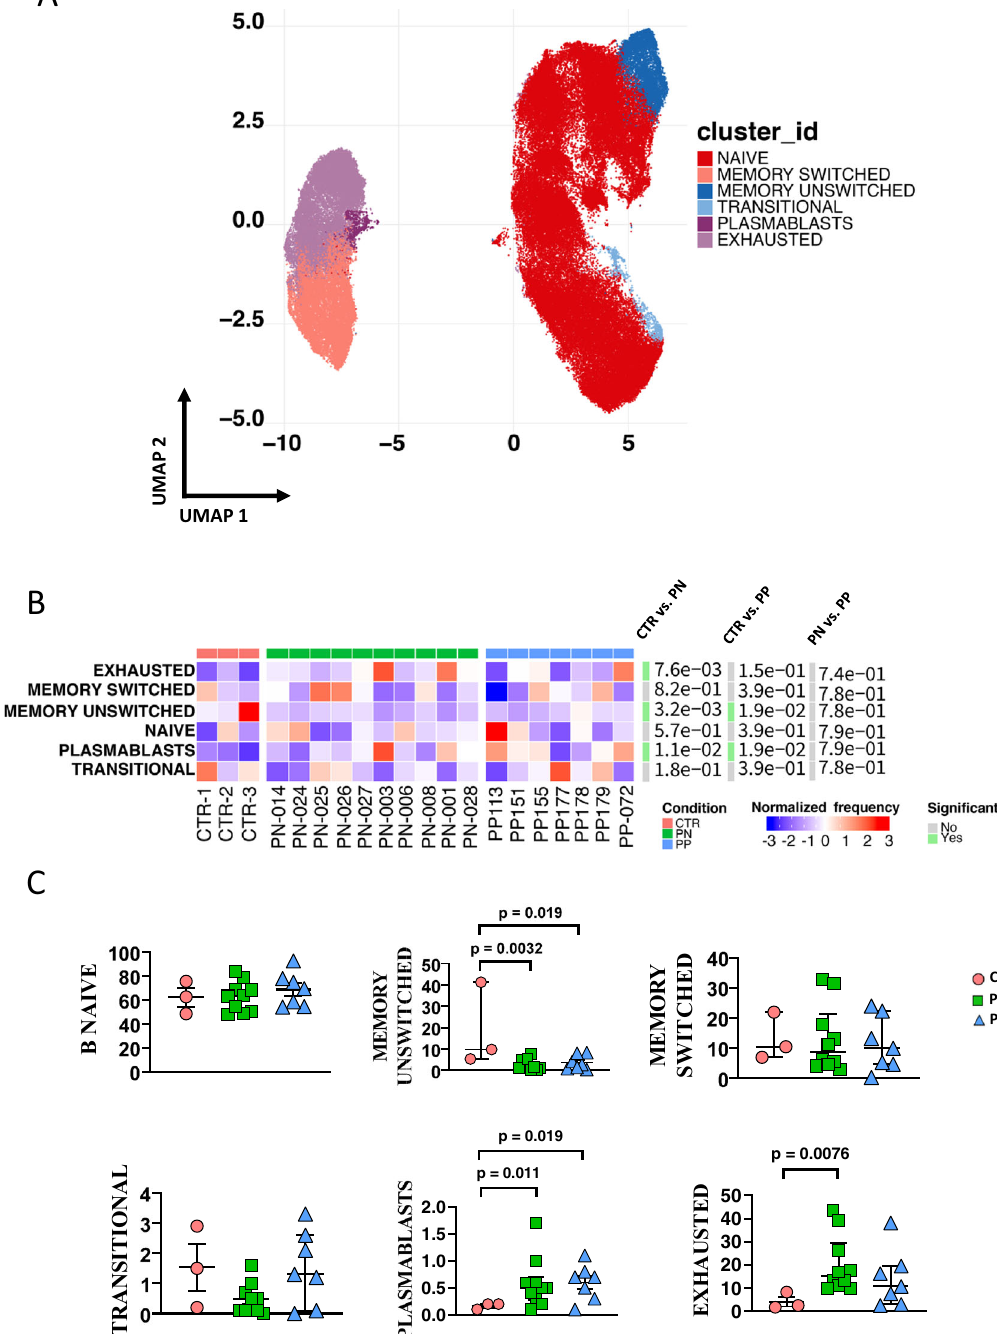
Fig. 5 Reclustering of CD19 + B cells reveals similar distribution of cells between infected or noninfected pregnant women and donors. A . Left panel: Uniform manifold approximation and projection (UMAP) representation of B-cell landscape. Each color indicates one of the six different clusters. B Differential analysis performed using generalized linear mixed model (GLMM) between nonpregnant women (CTR; bar color: salmon; n = 3), uninfected pregnant women (PN; green, n = 10), and infected pregnant women (PP; azure, n = 7). The heat represents arcsine-square-root-transformed cell frequencies that were subsequently normalized per cluster (rows) to mean of zero and standard deviation of one. The color of the heat varies from blue indicating relative underrepresentation to red indicating relative overrepresentation. Bar and numbers at the right indicate signi fi cant differentially abundant clusters (green) and adjusted p values. C Detailed statistical analysis of the different cell populations identi fi ed as in panel A . Comparison among infected pregnant women (PP) vs. uninfected pregnant (PN) or vs. healthy donors (CTR). The dot plots show the relative abundancies of six populations found within B cells. Values (dots) for the three conditions are matched with the color used in B . Data represent individual percentage values (dots), median (center bar), and SEM (upper and lower bars). Generalized linear mixed model (GLMM) with Bonferroni correction has been used. The exact p -value is indicated in the fi gure. Source data are provided as a Source Data fi